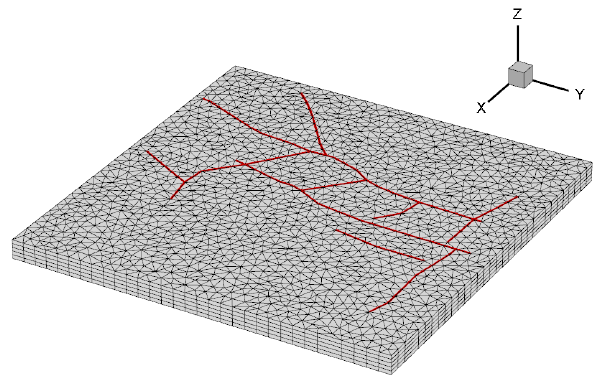
Figure 11. Prismatic meshing of heterogeneous